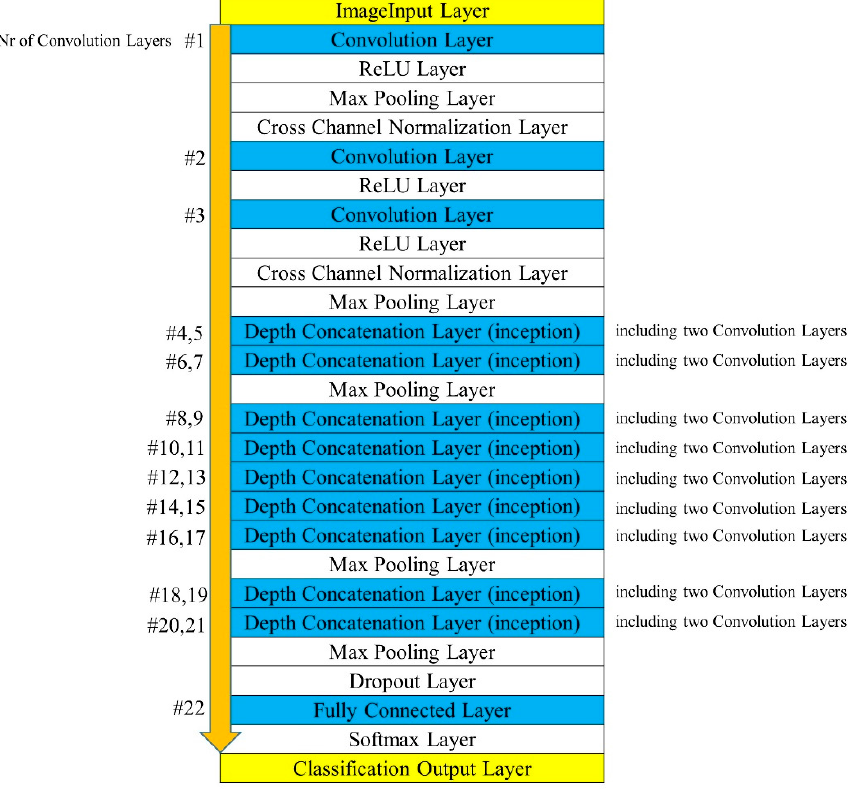
Figure 3 . The CNN architecture, which has 22 convolutional layers.